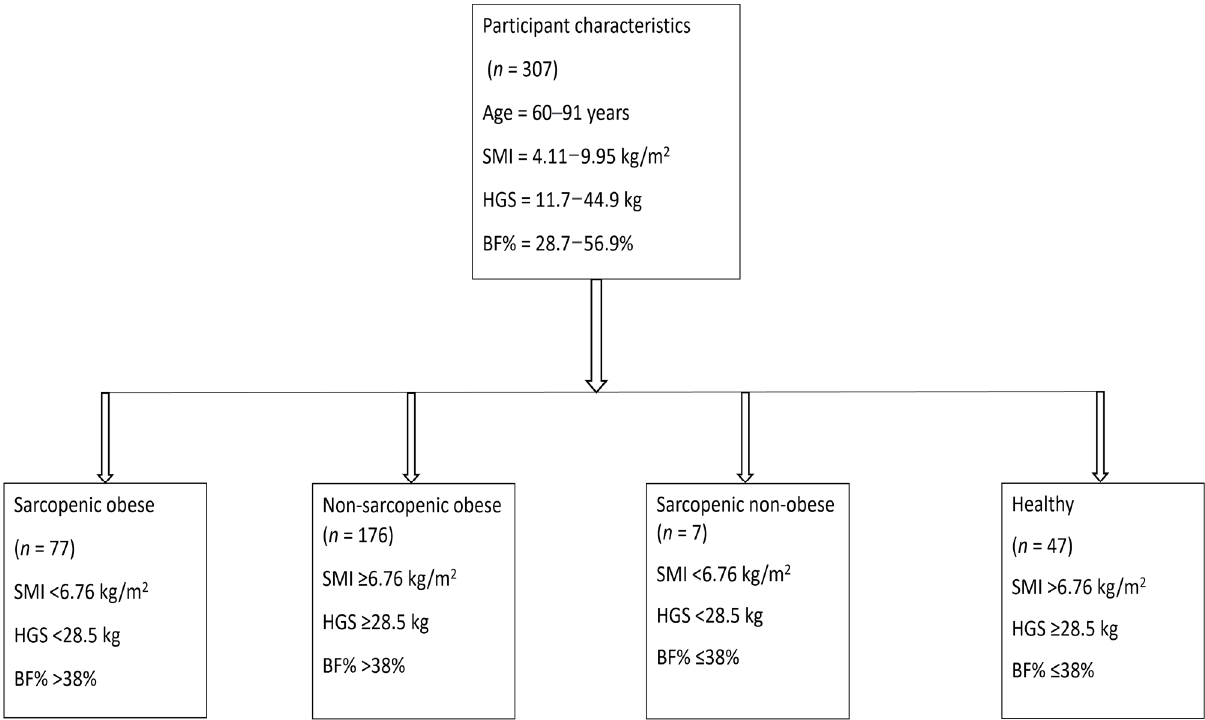
Figure 1. Flowchart showing the classification of participants into four categories: sarcopenic-obese, non-sarcopenic obese, sarcopenic non-obese, and non-sarcopenic non-obese groups. Abbreviations: SMI, skeletal muscle index; HGS, handgrip strength; BF%, body fat percent.